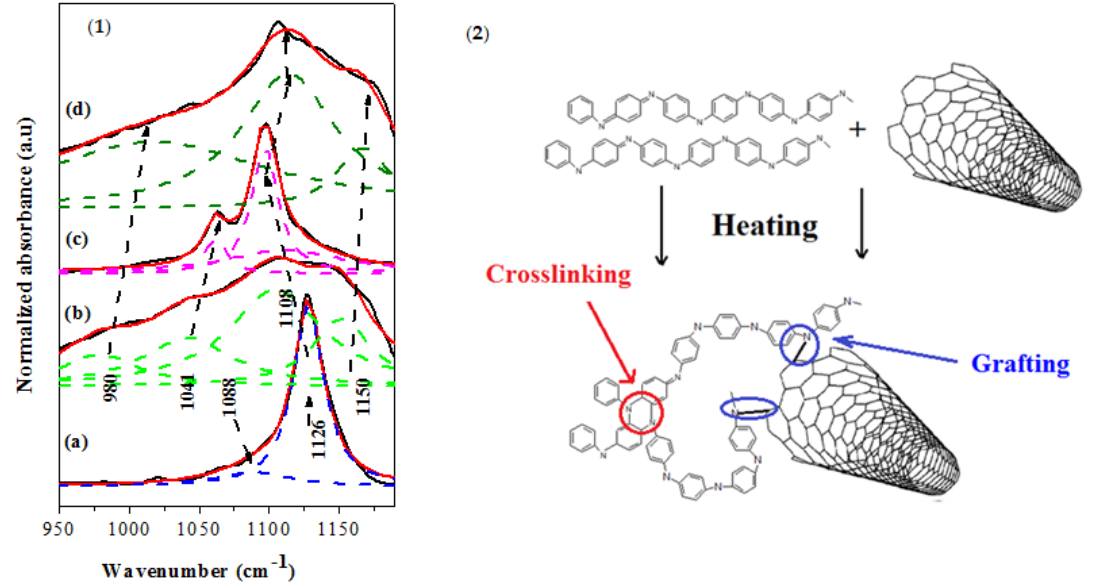
Figure 17. ( 1 ) Splitting of the FTIR band at 1126 cm − 1 under annealing: pure PANI ( a ), annealed PANI ( b ), not-annealed composite ( c ), and annealed composite ( d ). ( 2 ) Structure of the nanocomposite obtained after annealing at 393